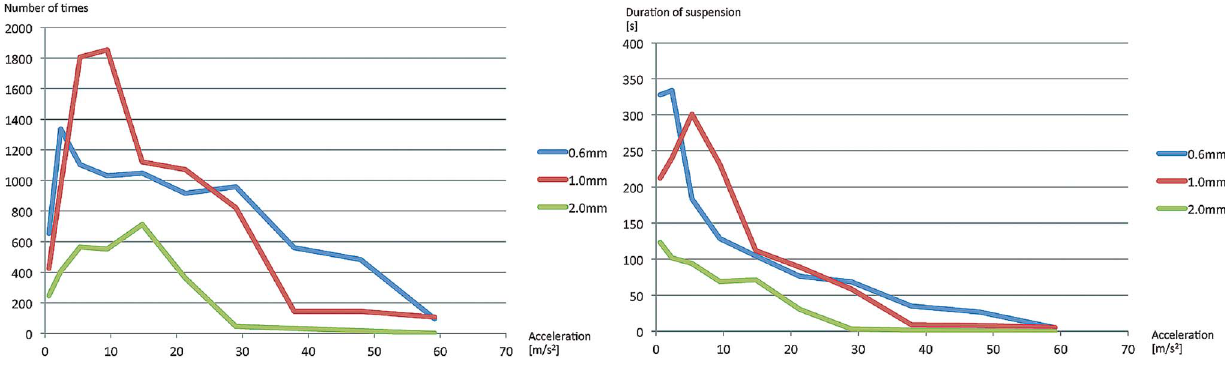
Figure 5. Results of stability experiments on different sizes of particles. The horizontal axis shows the maximum acceleration (cm/s 2 ) within back-and-forth motion. The blue, red, and green lines show the results of 0.6 mm, 1.0 mm, and 2.0 mm, respectively. (Left) The vertical axis shows the average number of times (the duration divided by the periodic time). (Right) The vertical axis shows the average duration of suspension [s]. Both show the same experimental results.